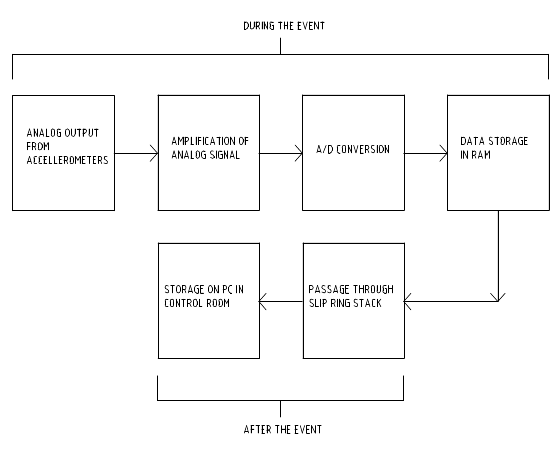
Fig. 3. Diagram of data acquisition time sequence.